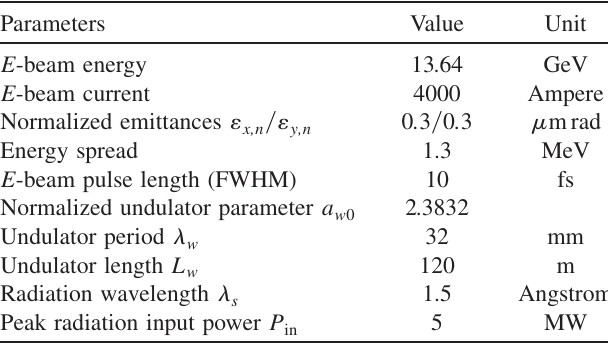
TABLE I. Main parameters for a hard x-ray tapered FEL with linearly polarized undulator.